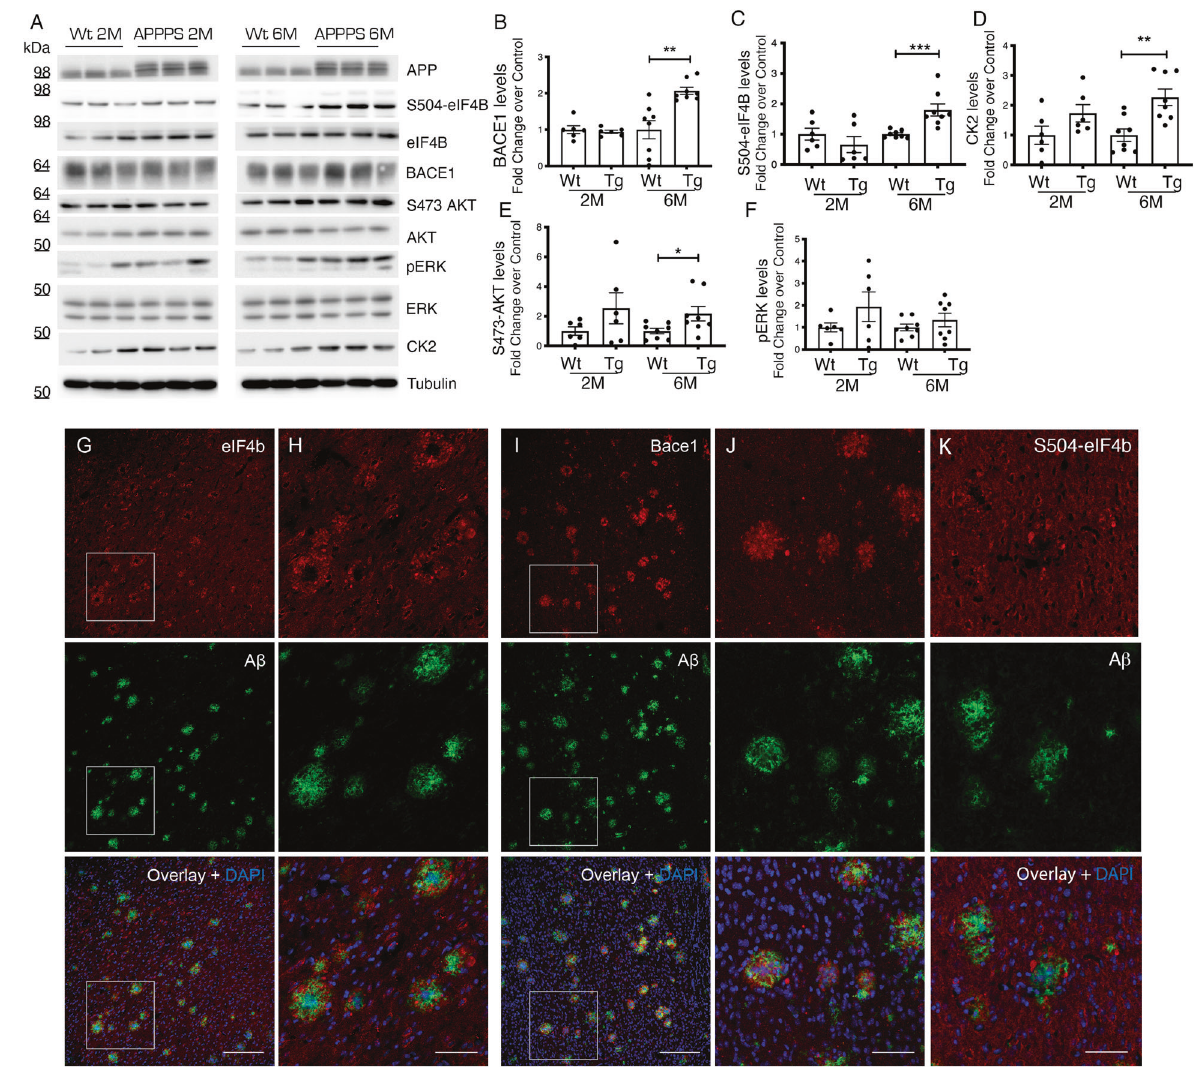
Fig. 4 Increased eIF4B expression and phosphorylation in the brains of APPPS1 mice. A – F Representative western blot ( A ) and quanti fi cation ( B – F ) of the indicated proteins in extracts from 2 (2 M) or 6 (6 M) months old brains from APPPS1 (APPPS) or wild-type (Wt) mice. Protein levels are shown as fold change over control (Wt mice). Levels of phosphorylated proteins are normalized against the corresponding total protein, then for loading (Tubulin) and shown as fold change over control (Wt mice). Statistical signi fi cance was